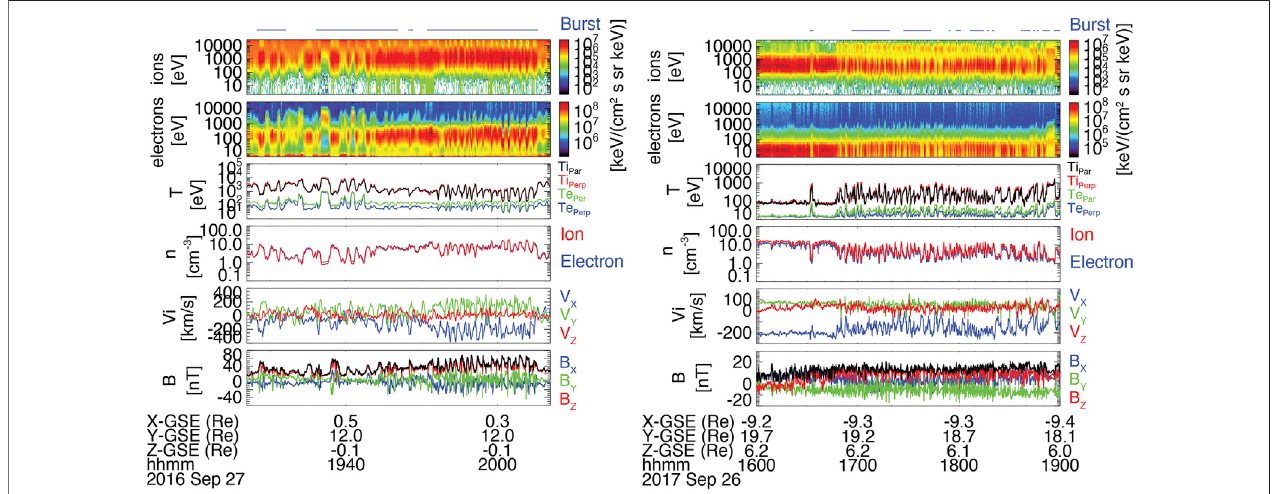
FIGURE5| OverviewofadditionalKHIeventsobservedbyMMSon (left) September27,2016and (right) September26,2016.Botharegiveninthesameformat as Figure 1 .